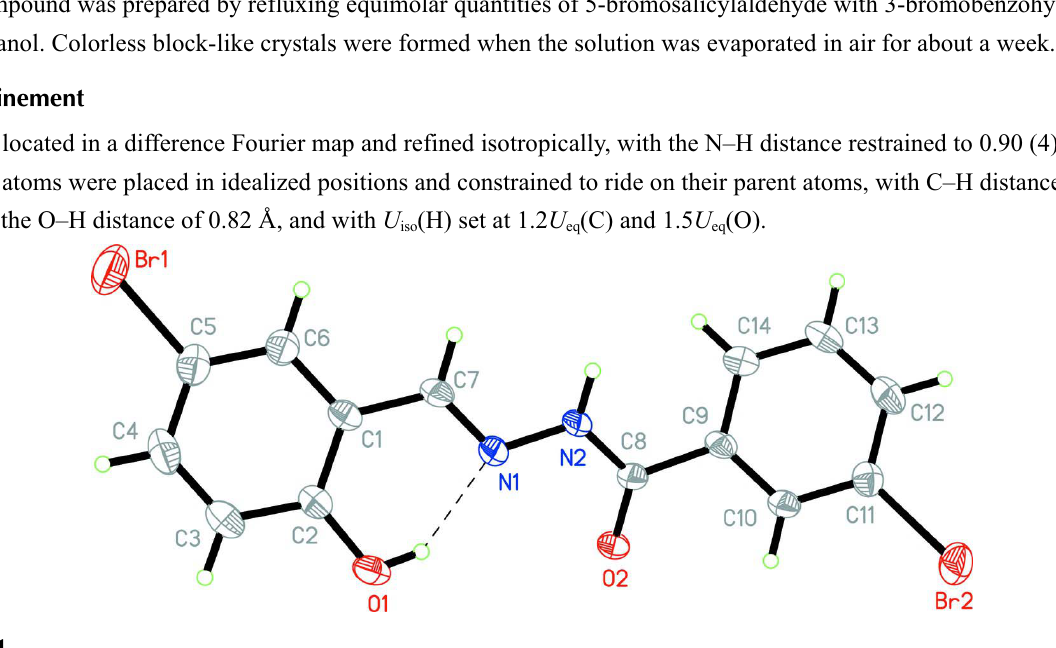
The molecular structure of (I) with ellipsoids drawn at the 30% probability level. Dashed lines indicate intramolecular hydrogen